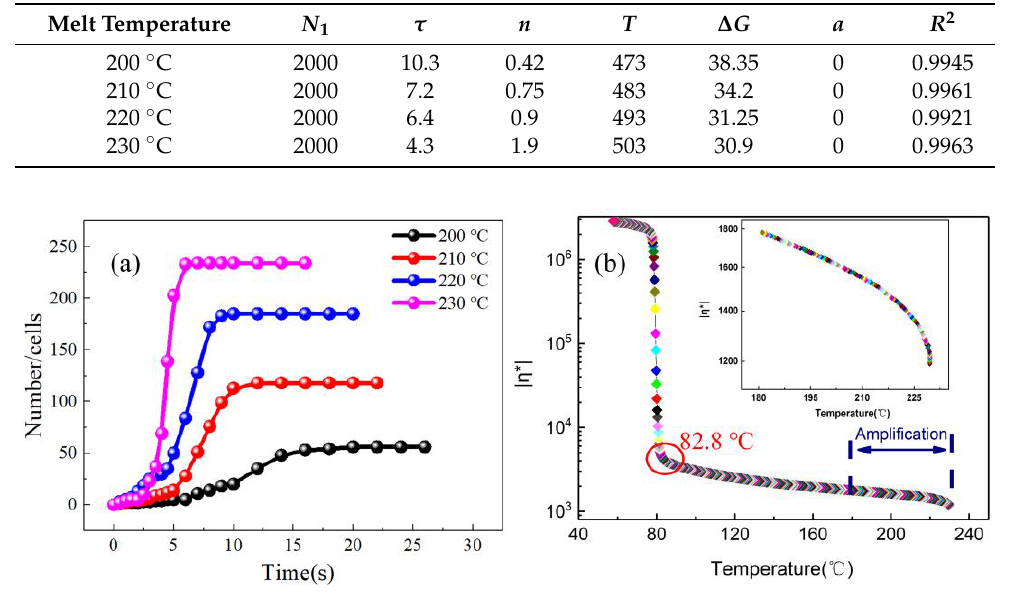
Figure 5. ( a ) The n -t curve comparison chart at 200 – 230 °C; ( b ) The curve of viscosity change with temperature.